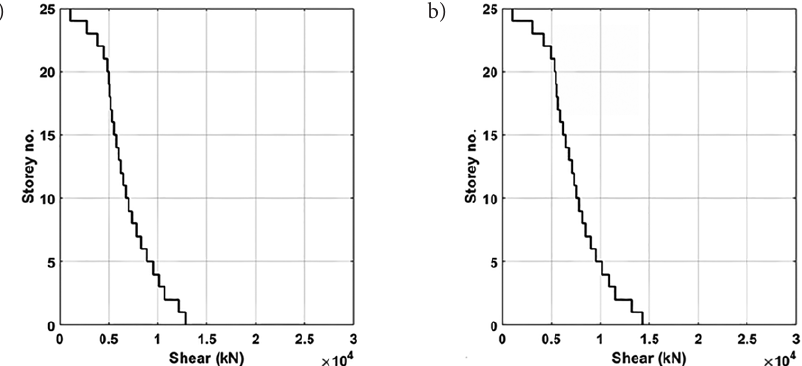
Figure 12. Peak story shear curves vs. story number under RS analysis in the: a – transverse direction and b –